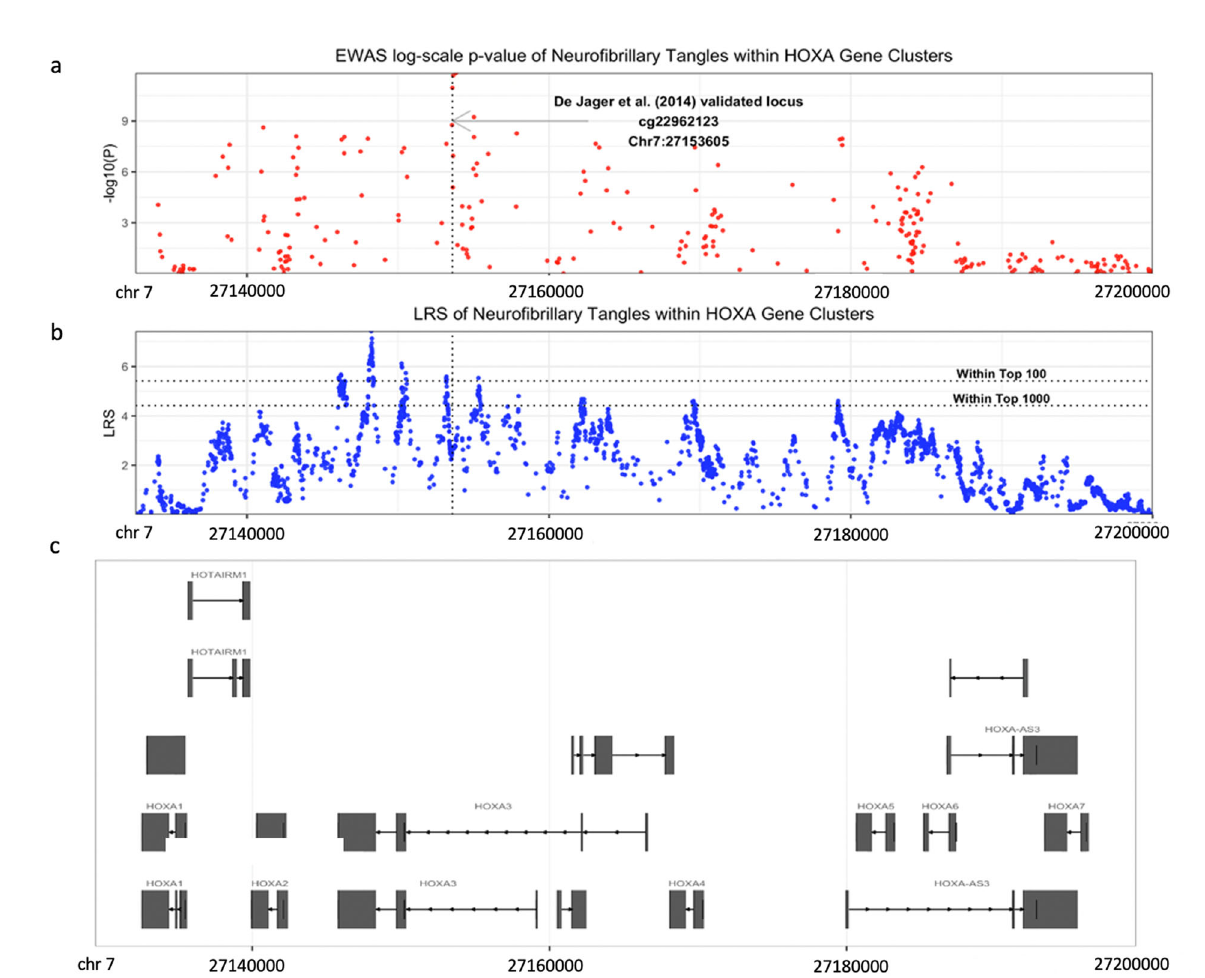
Fig. 4 Manhattan plot of neuro fi brillary tangles EWAS at the HoxA locus on chromosome 7. a Array-based EWAS p -values. The most signi fi cant CpG identi fi ed by De Jager et al. are shown with an arrow. b EWASplus predicted LRS. c The landscape of the HoxA cluster